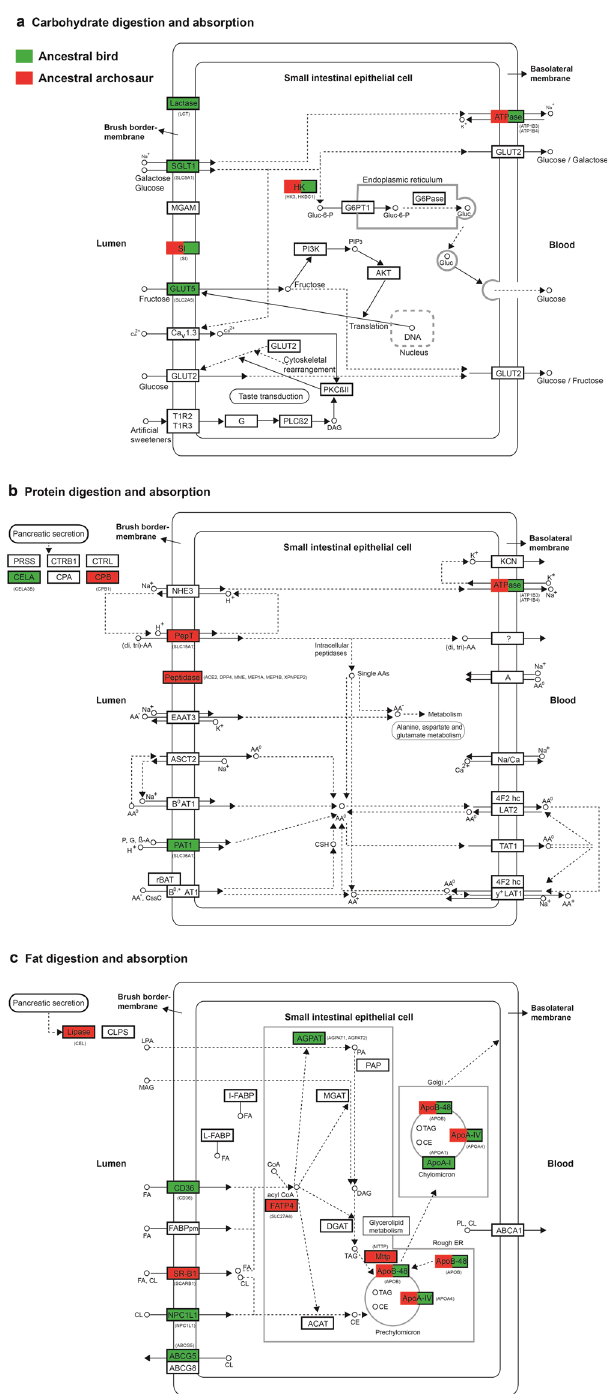
Fig. 2 Digestive system pathways and positively selected genes. The digestion and absorption of carbohydrates ( a ), proteins ( b ), and fats ( c ) are shown. The proteins with their corresponding genes in parentheses under positive selection are highlighted in red (ancestral archosaur) and green (ancestral bird). The three digestive system pathways are modi fi ed from corresponding KEGG pathways with accession numbers (map04973, map04974, and